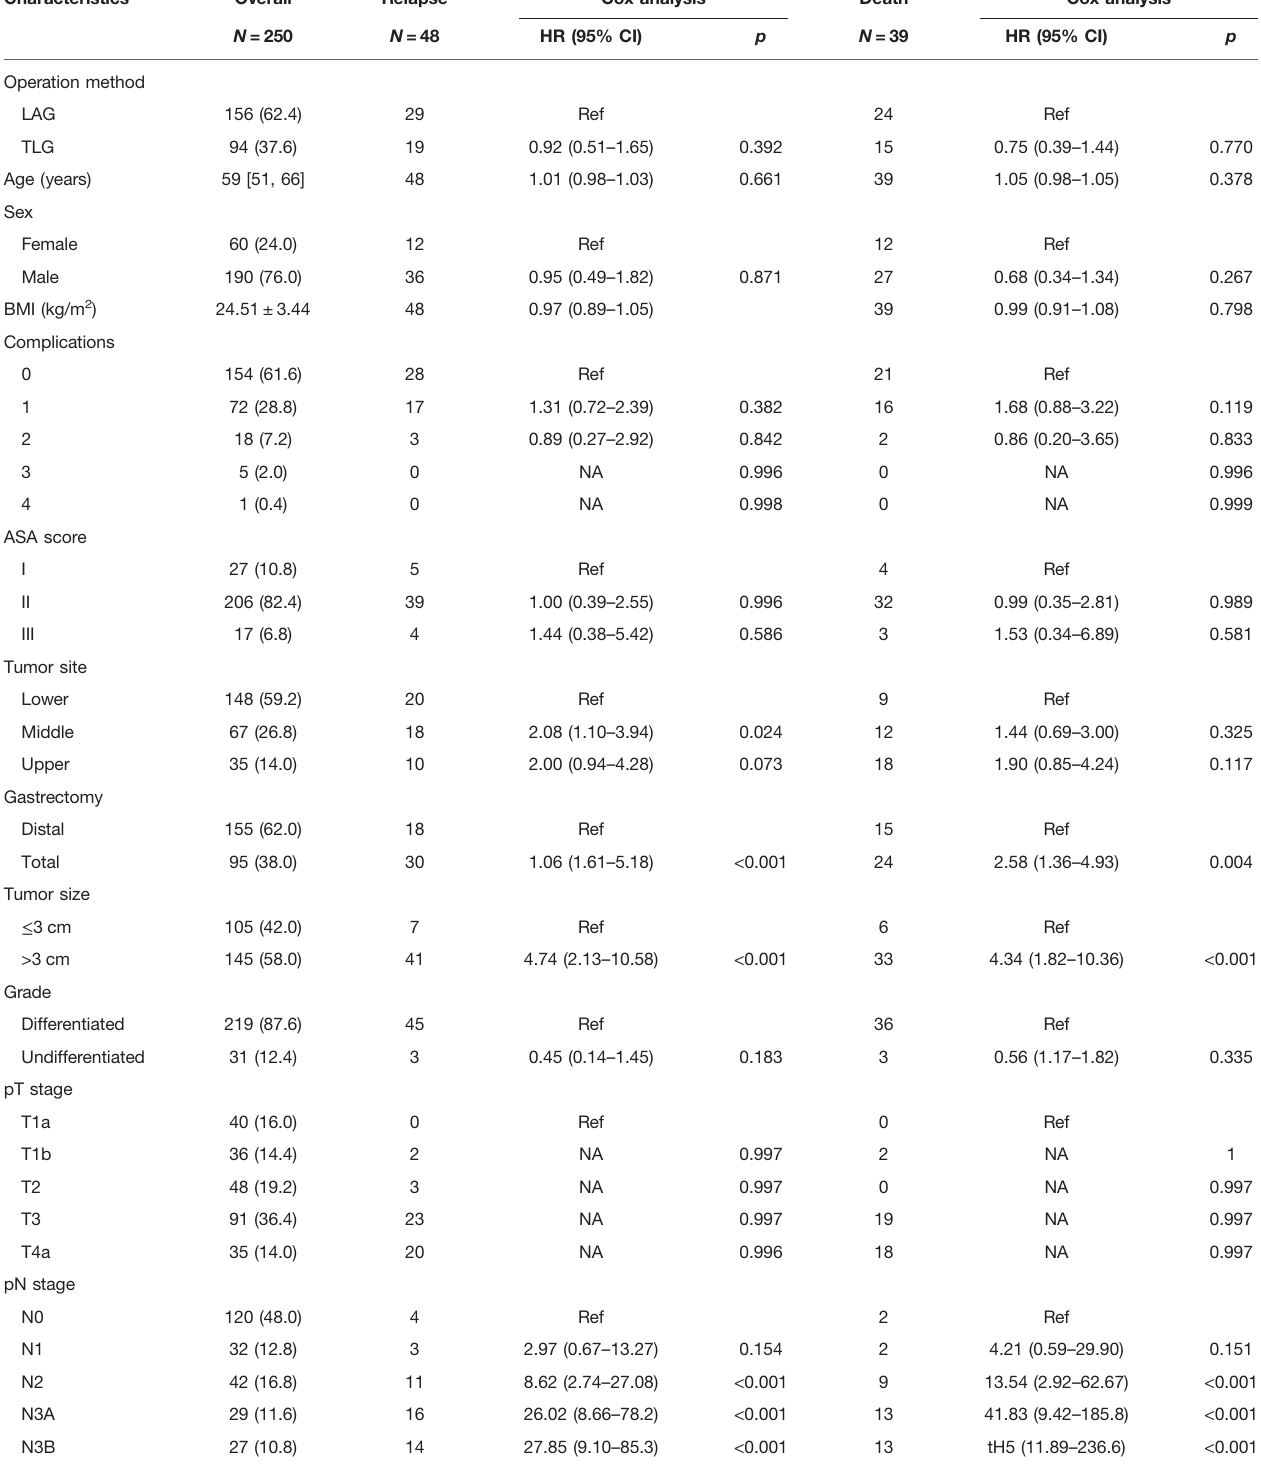
TABLE 1 | Patient demographic data and tumor